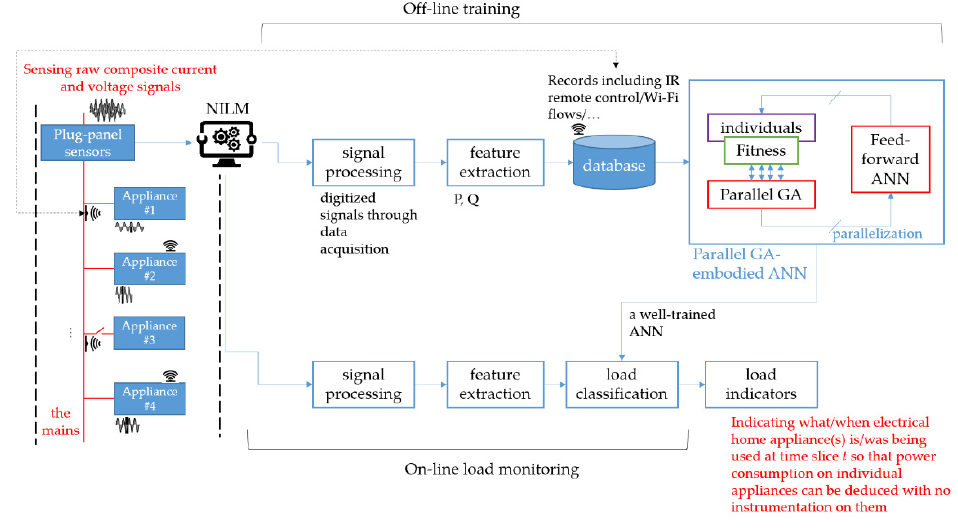
Figure 2. Workflow of the non-intrusive load monitoring (NILM) using a parallel genetic algorithm (GA)-embodied Artificial Neural Networks (ANN) for NILM in this work. The NILM is fully- nonintrusive that no instrumentation for (rated) power consumption on electrical appliances is required during the preliminary stage of the NILM involving the training process of the ANN for load classification.